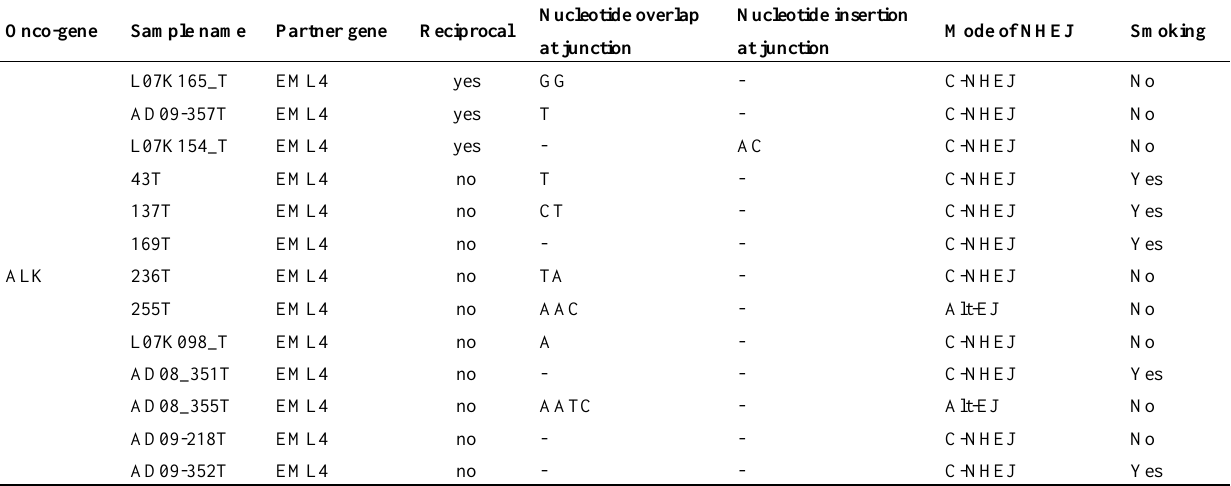
Table 2. Structure of breakpoint junctions for ALK , ROS1 , and RET fusions determined to be caused by